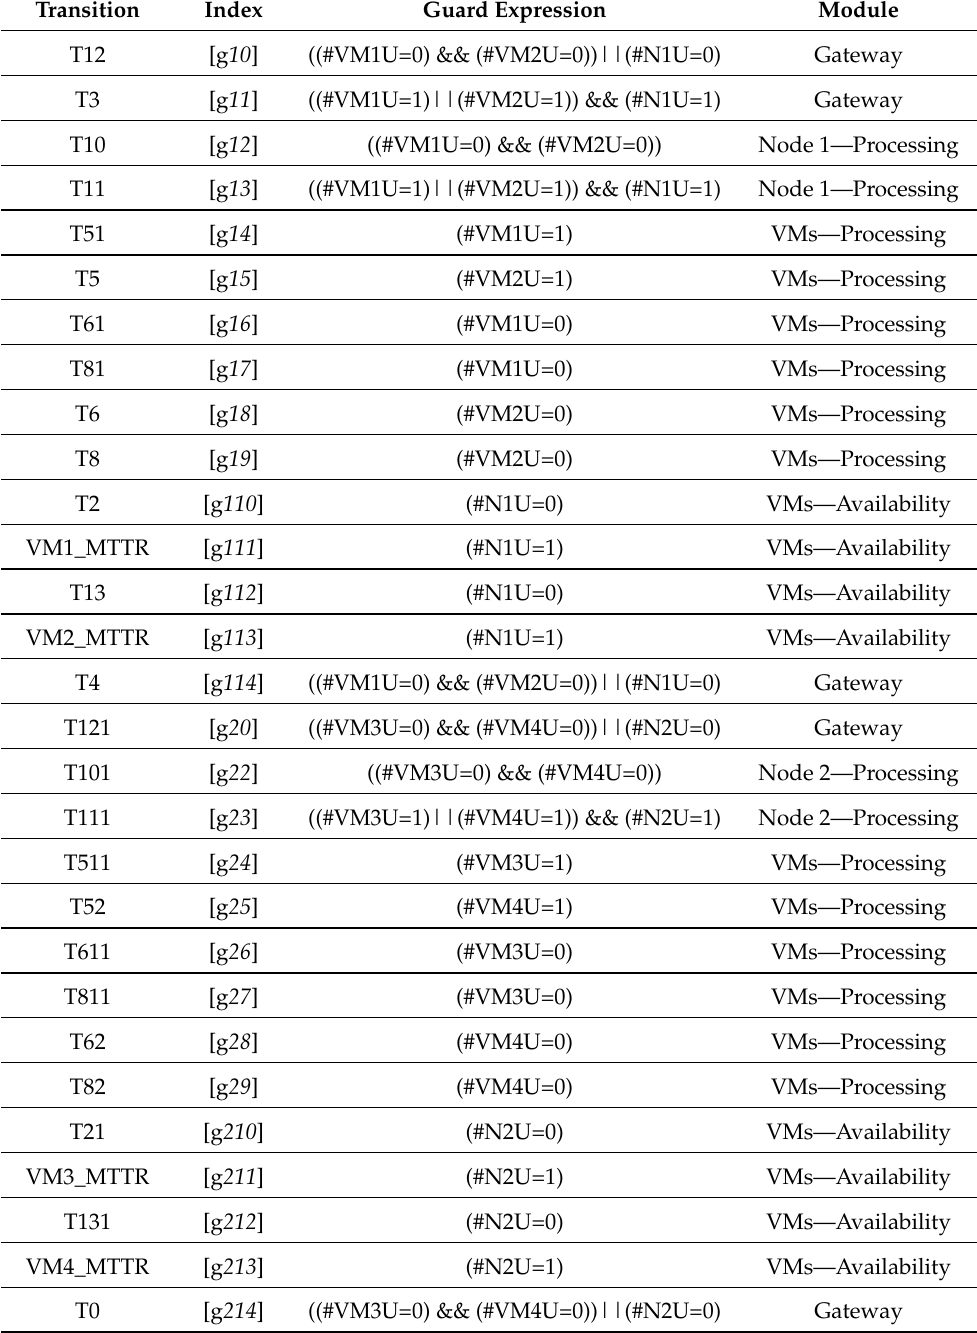
Table 2. Model Guard